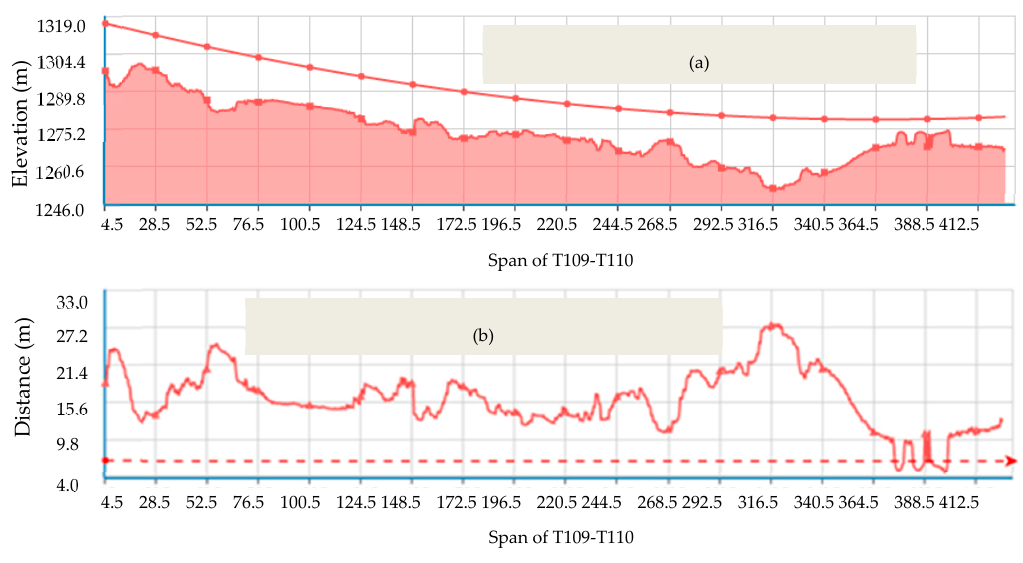
Figure 17. Diagram of the profile analysis results of the power line corridor between T109 and T110. ( a ) Profile of the power line and the ground; ( b ) Distance between the power line and the ground.